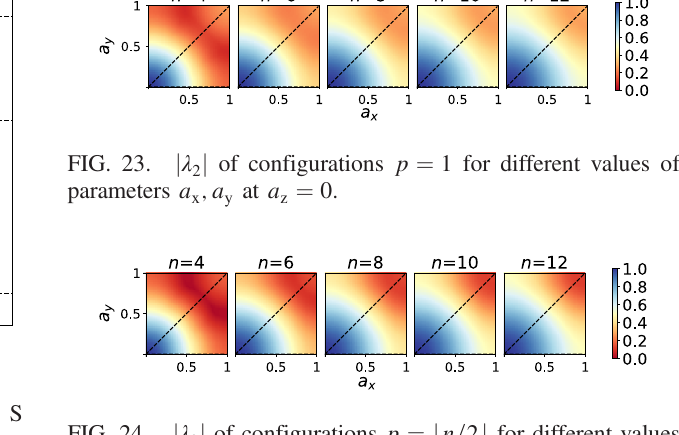
FIG. 24. j λ 2 j of configurations p ¼ b n= 2 c for different values ; a 0 of parameters a at a x y z ¼